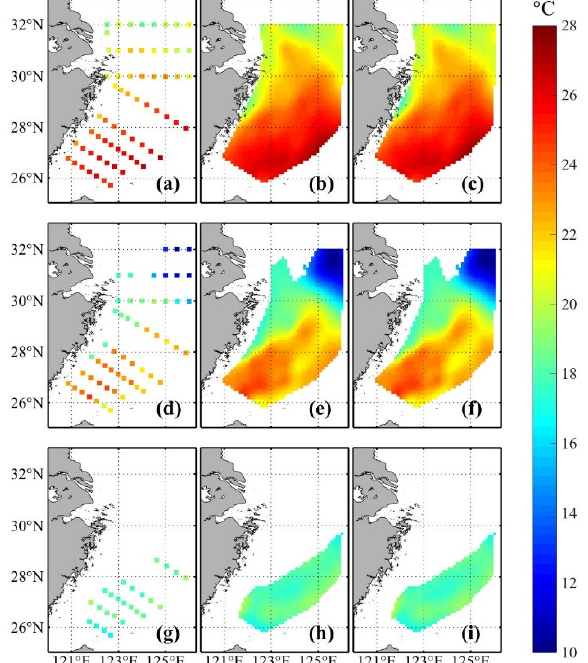
Figure 8. The in situ temperature (summer 2011) and results reconstructed with different RBFs in the ECS shelf. The first column presents the in situ observations, the second is the interpolation result using the thin plate spline RBF method, and the last column uses the cubic RBF method. ( a–c ) − 5 m depth; ( d–f ) − 45 m depth; and ( g–i ) − 85 m depth.